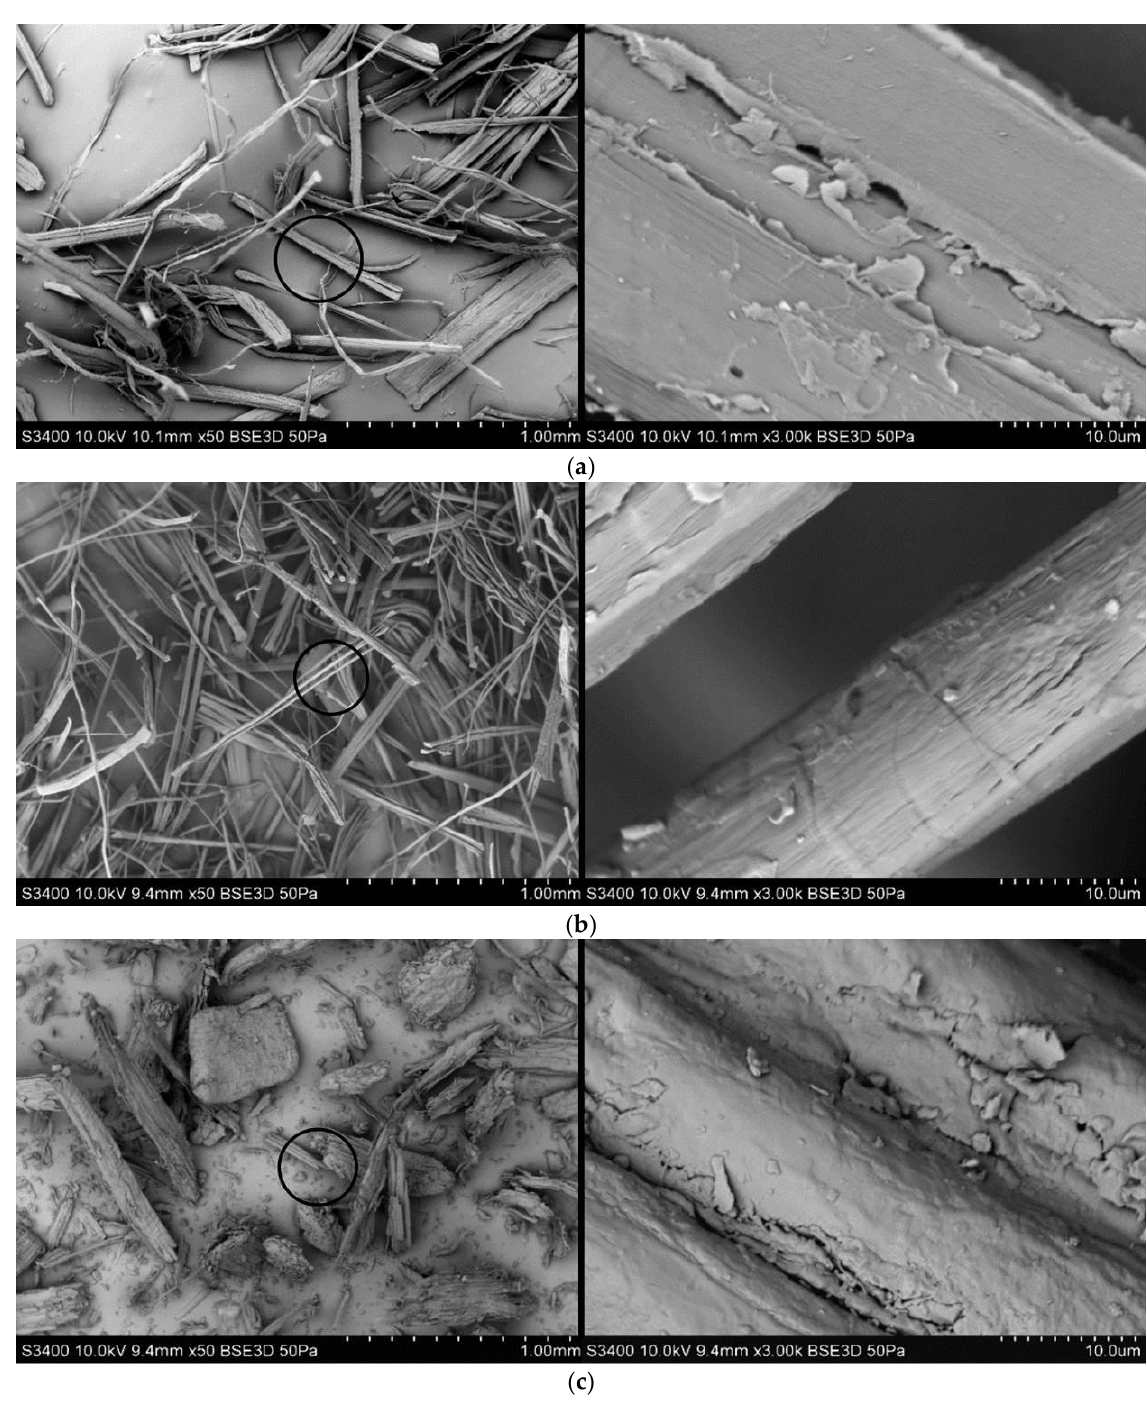
Figure 1. SEM photography of ( a ) hemp, ( b ) flax and ( c ) wood